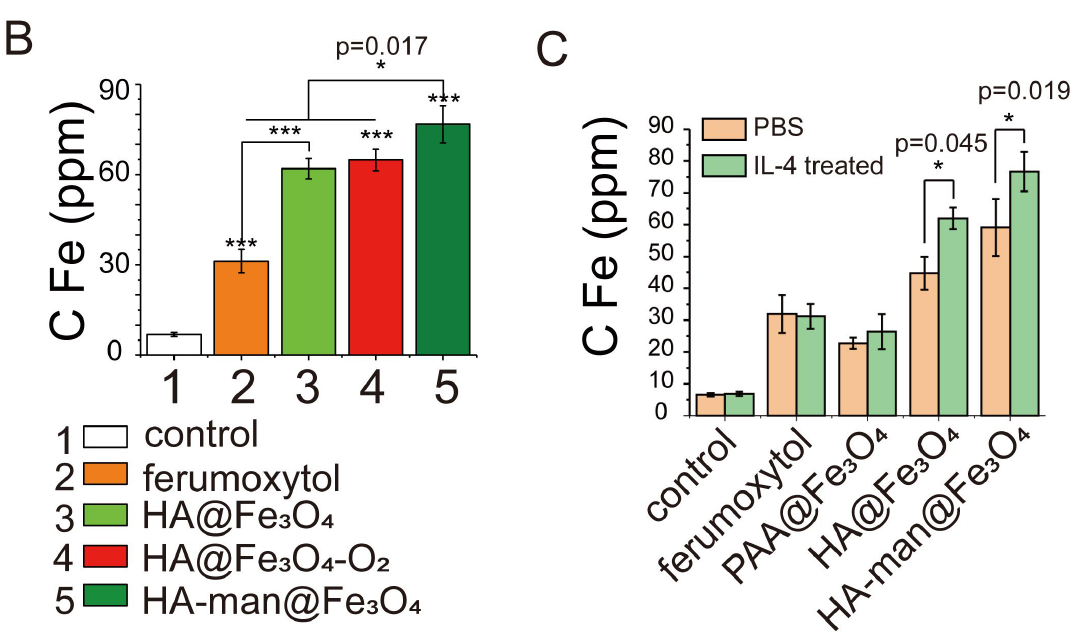
Figure 2. RAW264.7 cells cocultured with different iron oxides in vitro. ( A ) Prussian blue staining images of RAW 264.7 cells; ( B ) Fe amount in RAW 264.7 cells. Cells were incubated with 200 μg mL −1 iron oxides in Fe for 24 h. ( C ) The targeting abilities of iron oxide nanoparticles with different coating molecules towards macrophages. PBS or IL-4 stimulated RAW264.7 cells were cocultured with materials for 24 h before testing. Error bars indicate at least three independent experiments. p -value has been calculated by the one-way ANOVA test. * p < 0.05 and *** p < 0.001.